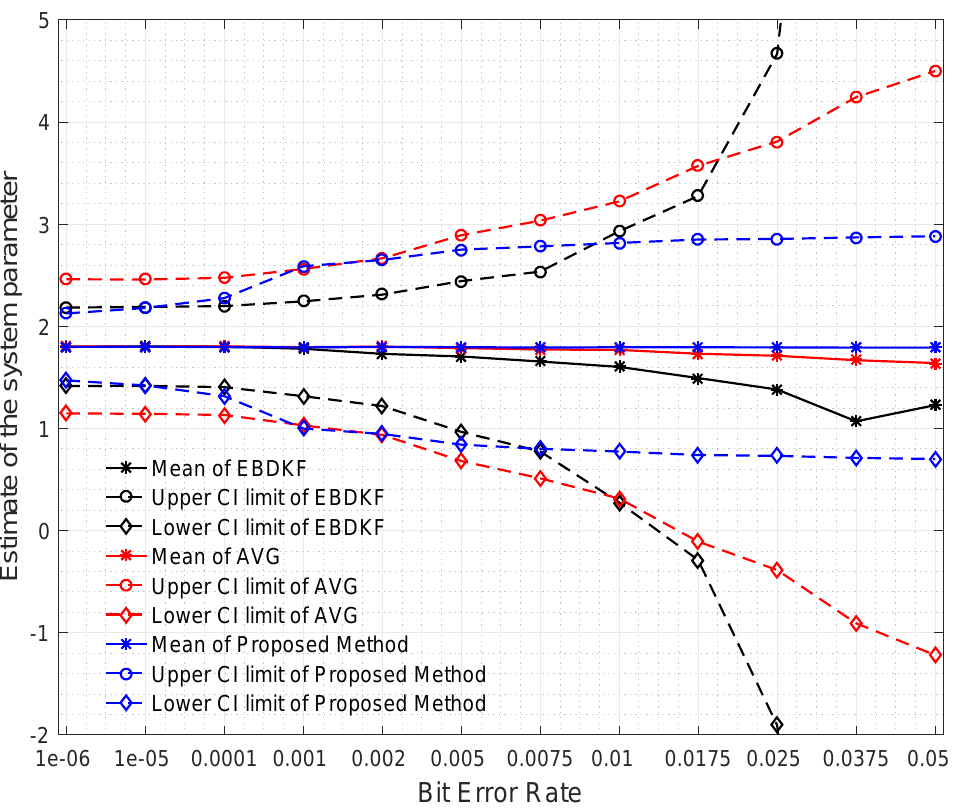
Figure 5. Network Mean estimate and 95% confidence interval limits for a true state of 1.80 compared among the proposed statistical, EBDKF and AVG information fusion methods in a chain-based IoT platform for different